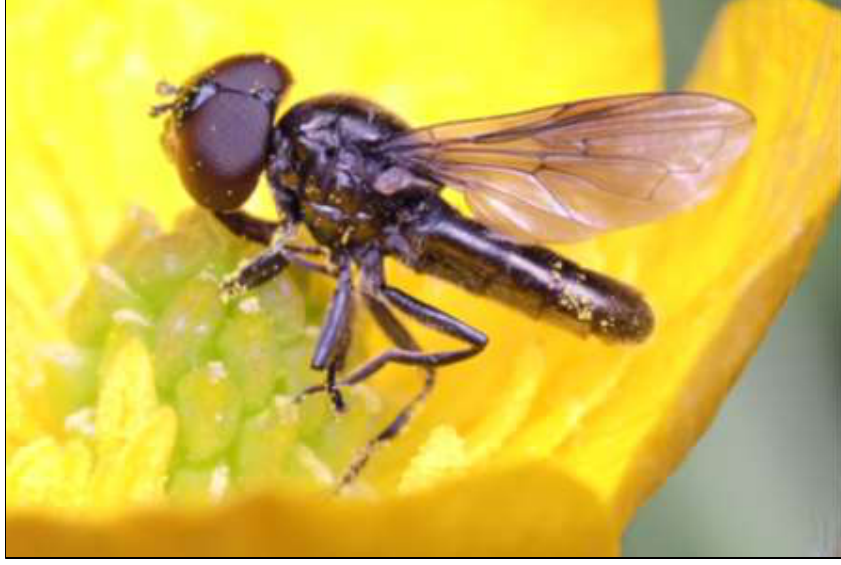
Figure 3. Melanogaster parumplicata (Loew, 1840), habitus of male, lateral view. (Photo: I. Parenta, 2021)